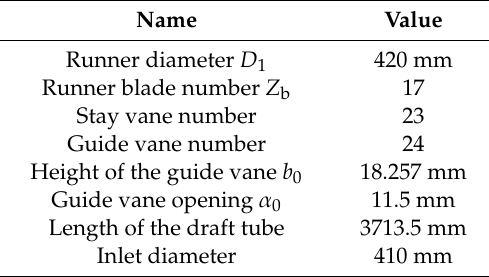
Table 1. Model turbine structure.